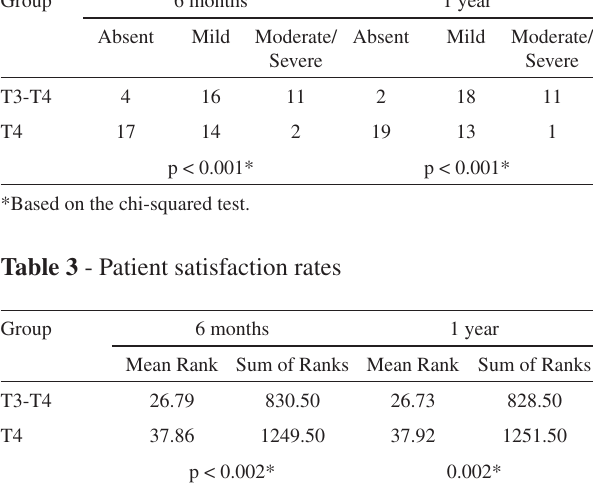
Mean Rank Sum of Ranks